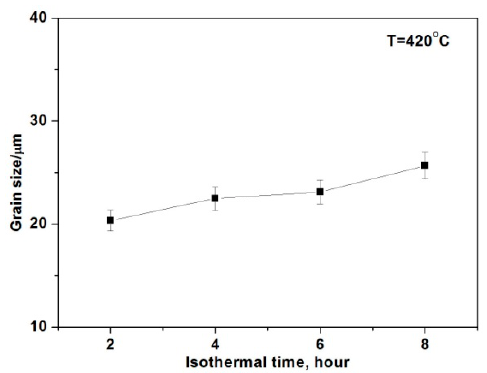
Figure 5. Average grain size of spray-casted AZ91D+0.75Ce alloy after annealed at 420 ◦ C for different times.